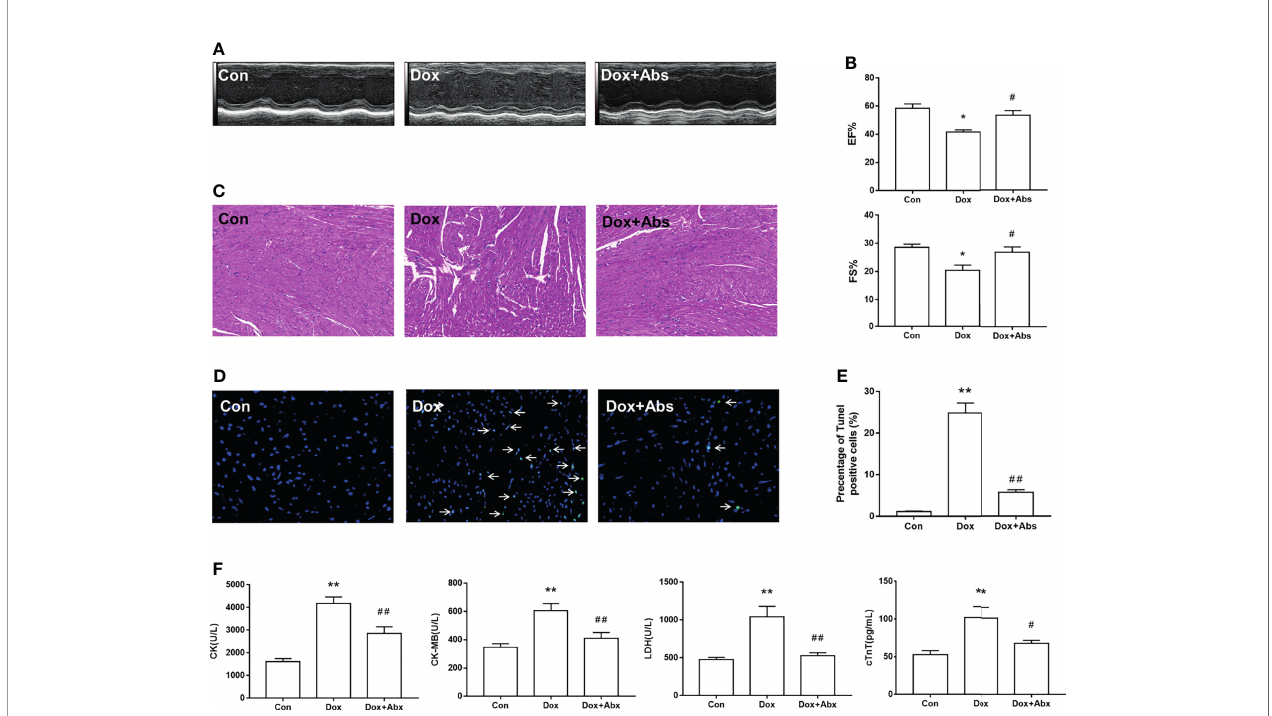
FIGURE 9 | The effect of Abs on the Dox-induced cardiac dysfunction and histological injury. (A) M-mode echocardiograms showing Abs treatment attenuated the Dox-induced left ventricular dilation. (B) The parameters of left ventricular ejection fraction (EF%) and left ventricular fractional shortening (FS%). (C) H&E staining re fl ected the histological changes, magni fi cation ×200. (D) Representative image of TUNEL staining, magni fi cation ×400; white arrows indicate the apoptotic cells. (E) Statistical result of TUNEL staining. (F) The serum level of creatine kinase (CK), creatine kinase-MB (CK-MB), lactic dehydrogenase (LDH), and cardiac troponin T (cTnT). Con, control; Dox, doxorubicin; Abs, antibiotics. Data are mean ± SEM. n = 6 – 10. * p < 0.05, ** p < 0.01 vs. Con; # p < 0.05, ## p < 0.01 vs.